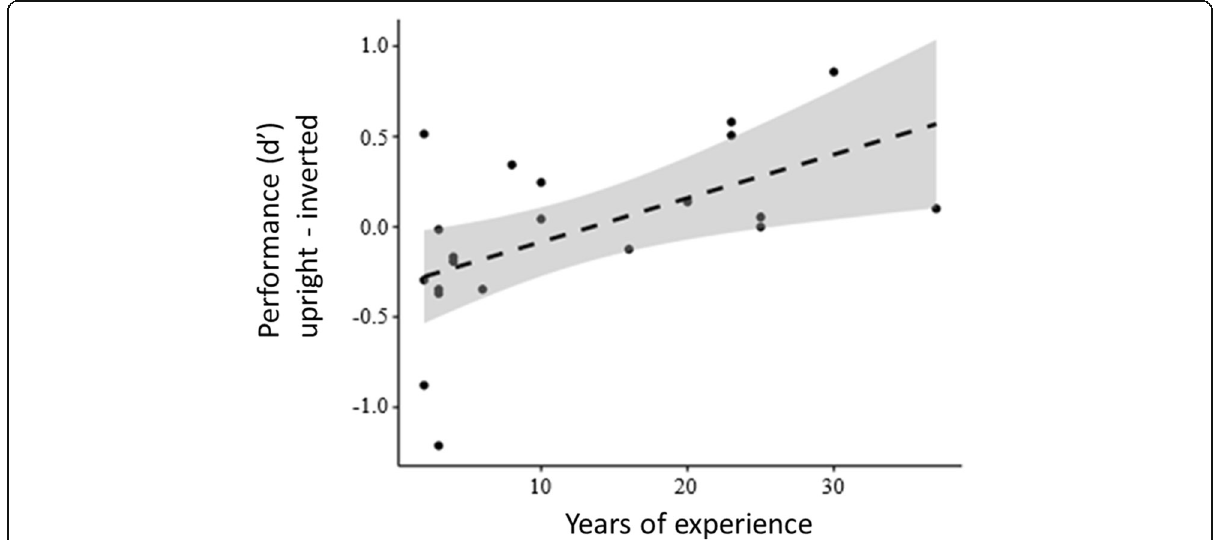
Fig. 6 An inversion composite score of upright mammogram performance ( d ’ score) minus the inverted mammogram condition performance across years of radiology